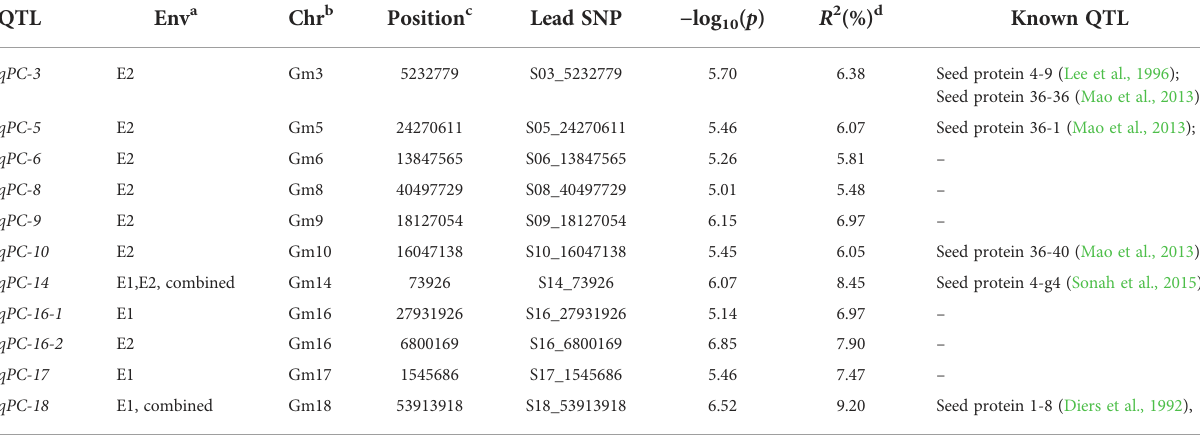
TABLE 2 Loci and SNPs signi fi cantly associated with protein content, predicted candidate genes and previously reported QTL for protein content at similar genome regions. QTL Env a Chr b Position c Lead